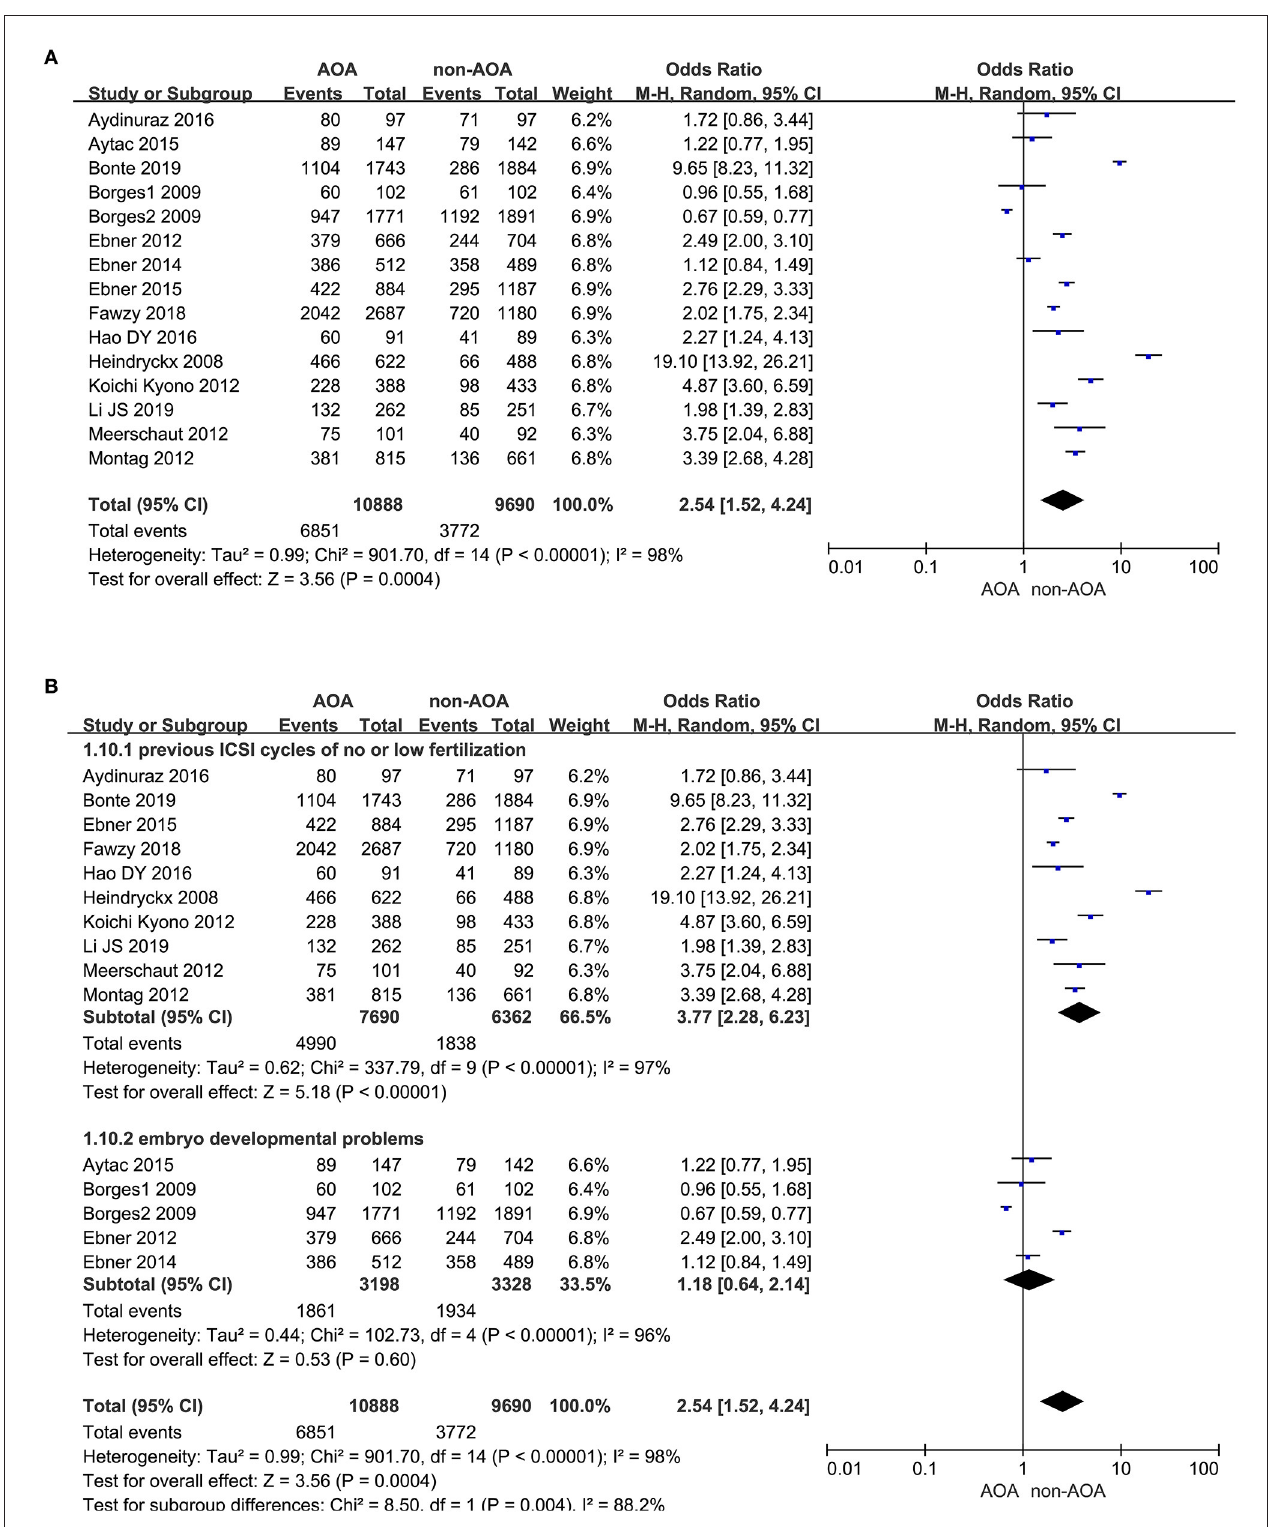
FIGURE 4 | (A) Forest plot of fertilization rate between AOA treatment and non-AOA treatment patient groups using calcium ionophore. (B) The subgroup analysis of fertilization rate between AOA treatment and non-AOA treatment patient groups.